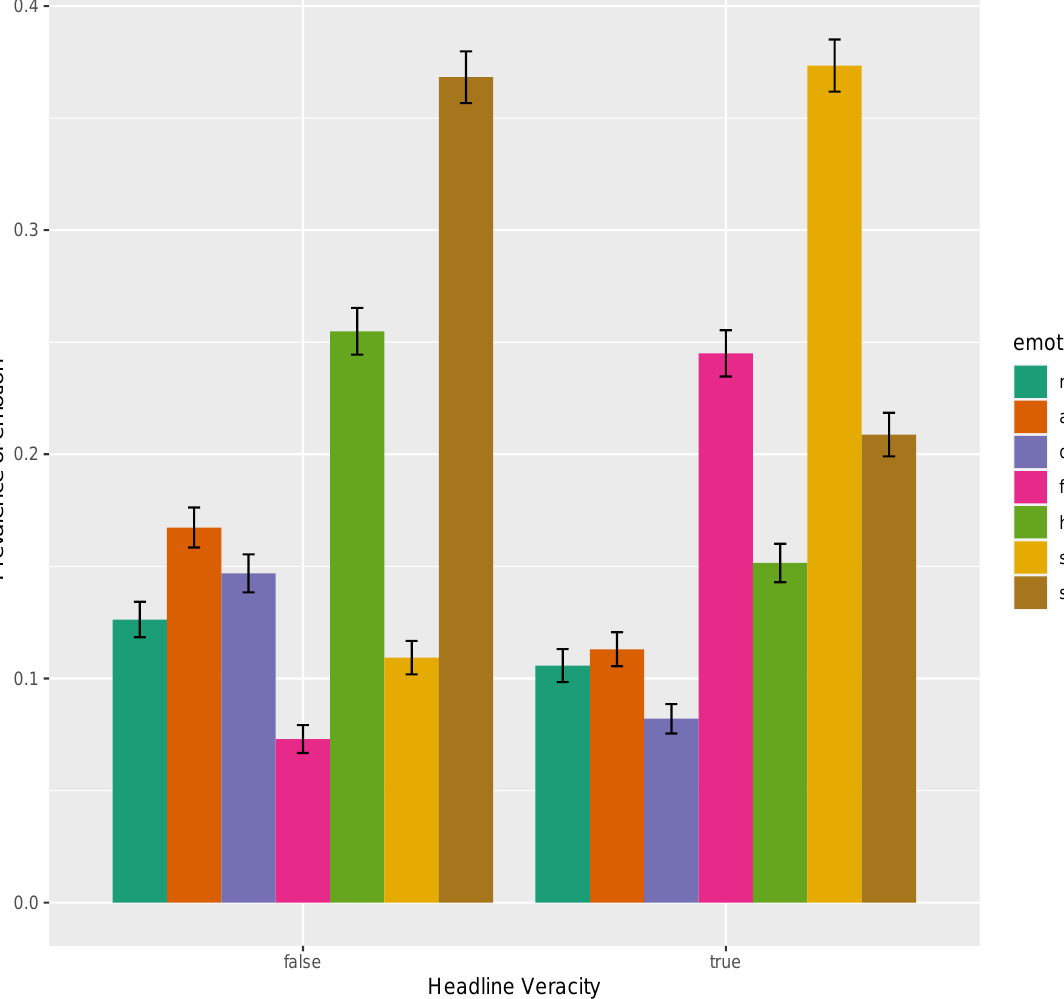
Figure D1. Prevalence of emotions by